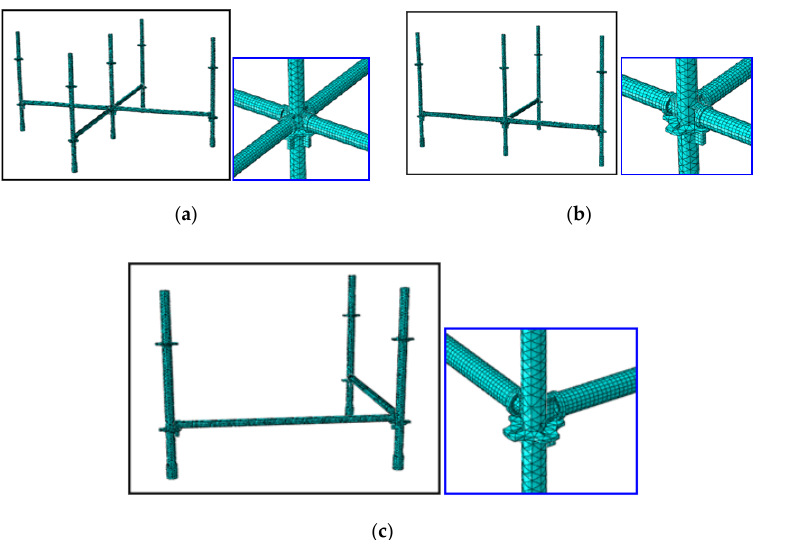
Figure 28. Finite element model of single-layer vertical pole for calculations of stability bearing capacity: ( a ) Central pole; ( b ) side pole; ( c ) corner pole.